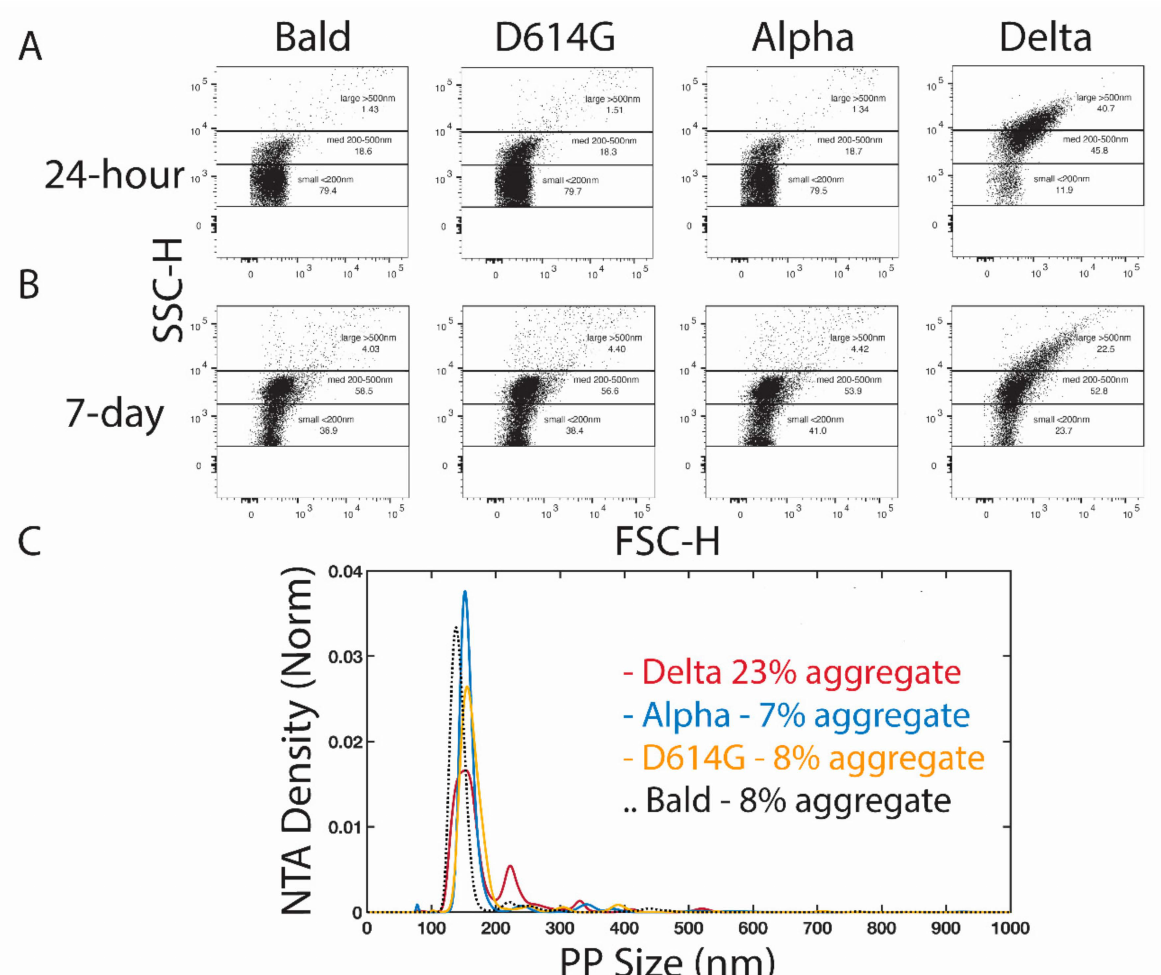
Figure 4. Flow cytometry and NTA detection of Delta PV aggregates. Representative flow cytometry of variant PVs conducted 24 h ( A ) and 7 days ( B ) post-harvest. A population of particles over 200 nm in size are present in the Delta PVs and are minimally (<10%) represented in the other PV variant samples. ( C ) NTA of the same samples of PVs at 24 h post-harvest shows about half as many particles in the single PV range in the Delta sample compared to the other variants, and detection of a larger proportion of PVs in